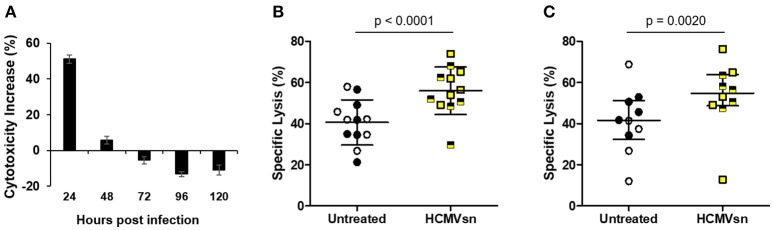
Effect of HCMVsn on NK cell cytotoxic responses of healthy controls. (A) CONsn or HCMVsn was collected at 24 h intervals up to 120 h post infection, diluted 1:5 and effects on NK cytotoxicity tested using fresh PBMC from healthy controls in 5 h 51Cr release assays. NK cell cytotoxicity with either CONsn or HCMVsn against (B) K562 cells (n = 12) or (C) anti-HLA-I-coated C1R-B27 cells (n = 10) was measured over 5 h at E:T 60:1. Subjects seropositive for HCMV are represented with filled black circles or yellow squares half-shaded black. Error bars in (A) represent mean ± standard deviation (SD) of two replicates, (B) mean ± SD with Student's paired t-test used for comparisons between conditions and (C) median with interquartile range (IQR) with Wilcoxon signed-rank test used to estimate the probability of a difference between conditions. Percent cytotoxicity increase in (A) was calculated as [(% specific lysis with HCMVsn – % specific lysis with CONsn)/% specific lysis with CONsn] × 100 from paired data performed in duplicate.